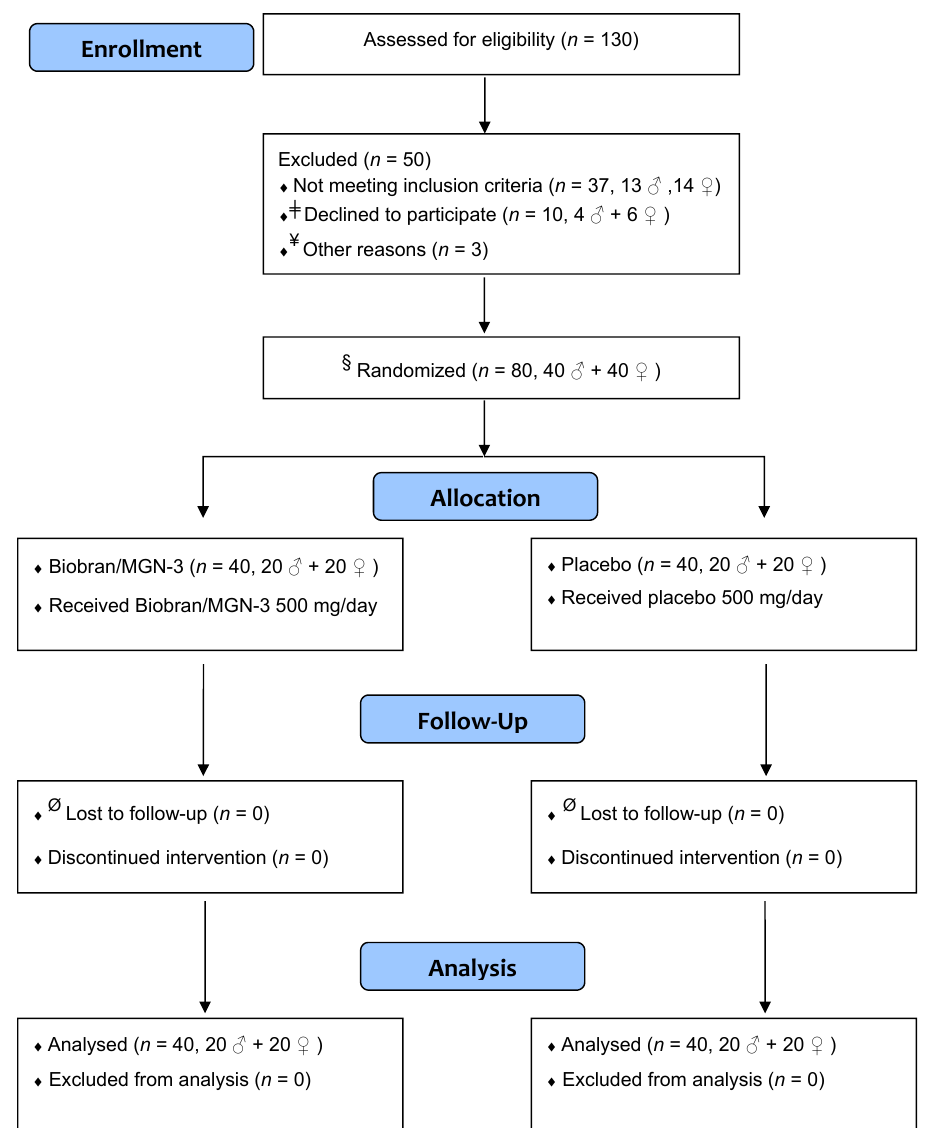
Figure 1. Simple flow diagram showing different stages of the clinical